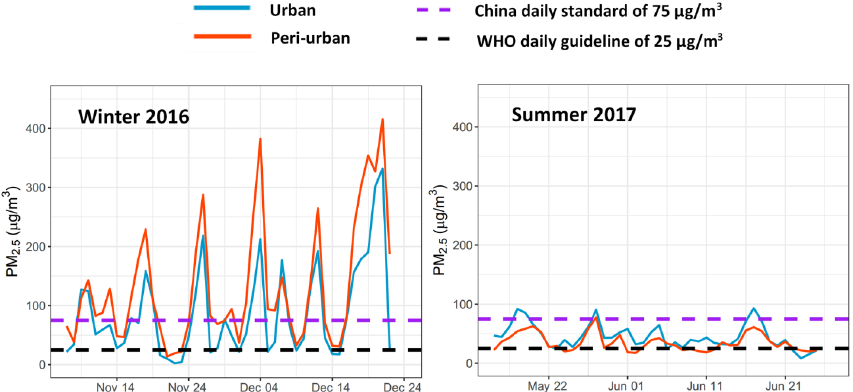
Figure 6. Seasonal and spatial trend of ambient PM 2 . 5 concentration during AIRLESS